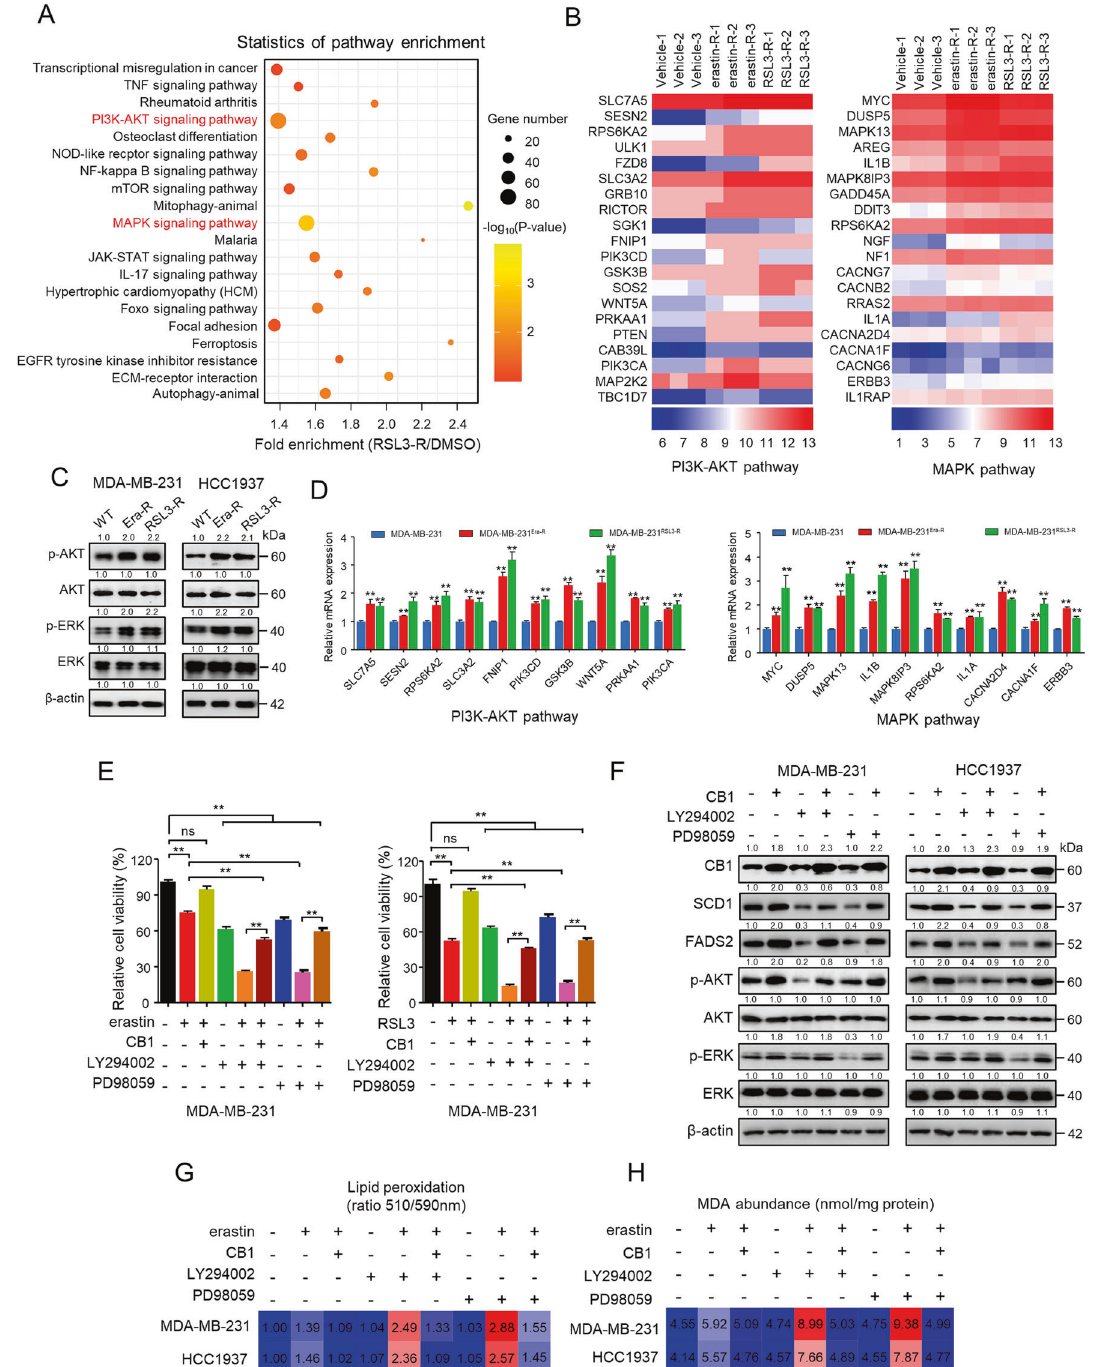
Fig. 5 PI3K-AKT and MAPK pathways were involved in CB1 repressed the ferroptosis sensitivity. A KEGG pathway analysis of differentially expressed genes in MDA-MB-231 cells transcriptome surviving from increased RSL3 treatment (RSL3-R) (The top 20 most signi fi cantly activated pathway are shown). B Heatmap of signi fi cantly regulated genes of MDA-MB-231 cells transcriptome surviving from increased erastin treatment (erastin-R) and RSL3 treatment (RSL3-R), respectively, correlated with PI3K-AKT pathway (left) and MAPK pathway (right) ( n = 3). C WB analysis of MDA-MB-231 and HCC1937 cells that were resistant to erastin (Era-R) and RSL3(RSL3-R), respectively. D qPCR analysis of the indicated gene expression associated with PI3K-AKT pathway (left) and MAPK pathway (right) in MDA-MB-231 cells that were resistant to erastin (MDA-MB-231 Era-R ) and RSL3 (MDA-MB-231 RSL3-R ), respectively, compared with parental MDA-MB-231 cells. ** p < 0.01 ( t -test). E The cell viability of MDA-MB-231 cells stably transfected with empty vector or CB1 treated with LY294002 (5 μ M) or PD98059 (10 μ M). The cell viability was assessed by CCK-8 assay after treatment for 72 h with the indicated doses of the drugs. ns (no signi fi cance), ** p < 0.01 (one-way ANOVA). F WB analysis of MDA-MB-231 and HCC1937 cells transfected with empty vector or CB1. Cells were treated with LY294002 (5 μ M) or PD98059 (10 μ M). G , H Effect of CB1 overexpression, LY294002 (5 μ M) and PD98059 (10 μ M) on lipid peroxidation ( G ) and MDA ( H ) response to erastin treatment, respectively, in MDA-MB-231 and HCC1937 cells. Data shown are mean ± SD of triplicate measurements that were repeated three times with similar